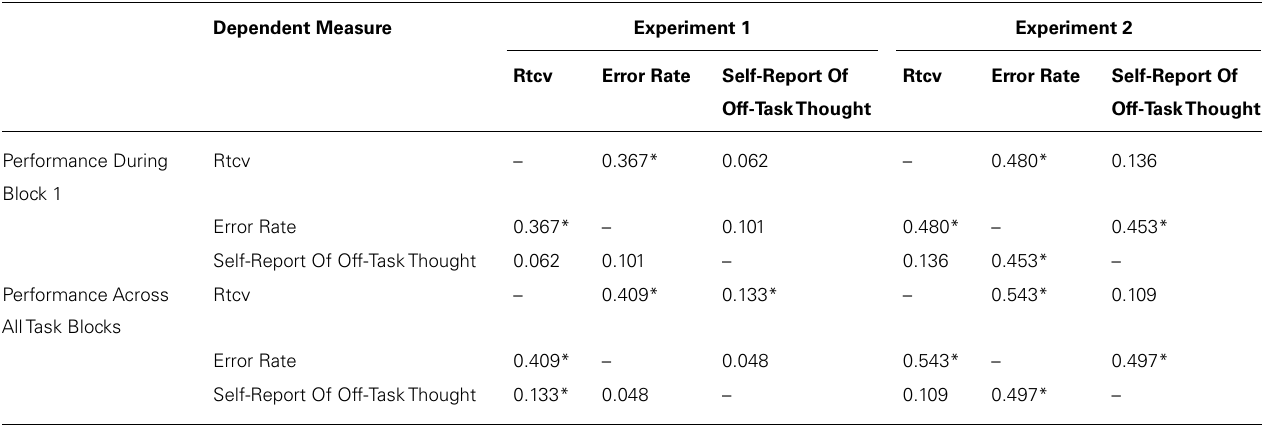
Table 2 | Correlations Between SART-Dependent Measures During Block 1AndAcrossTask Performance, For Both Experiments 1And 2. Dependent